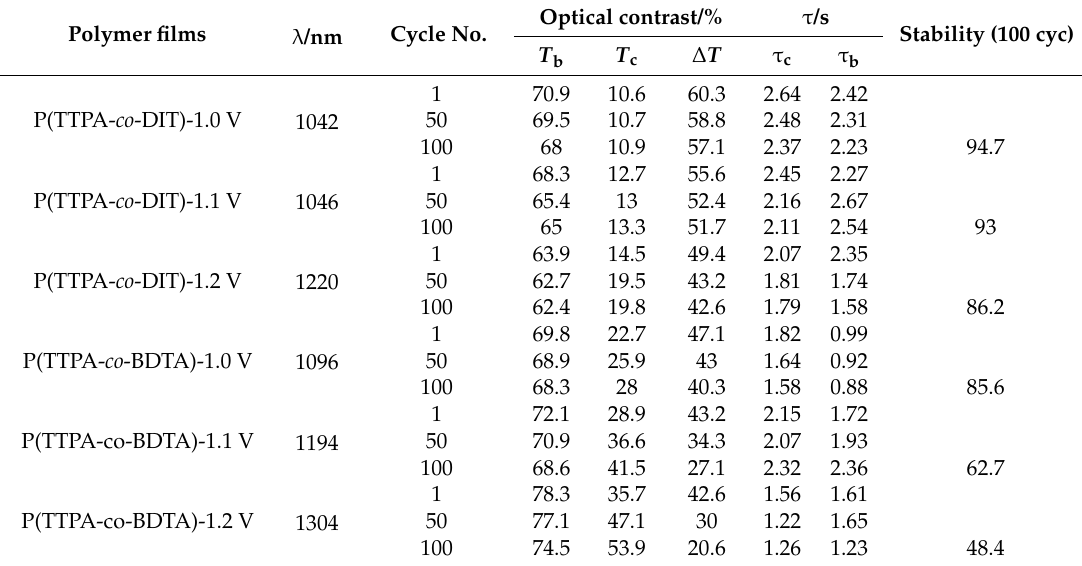
Table 3. Electrochromic photographs and colorimetric values (L*, a*, b*) of the copolymer films at various potentials in ionic liquid solution.